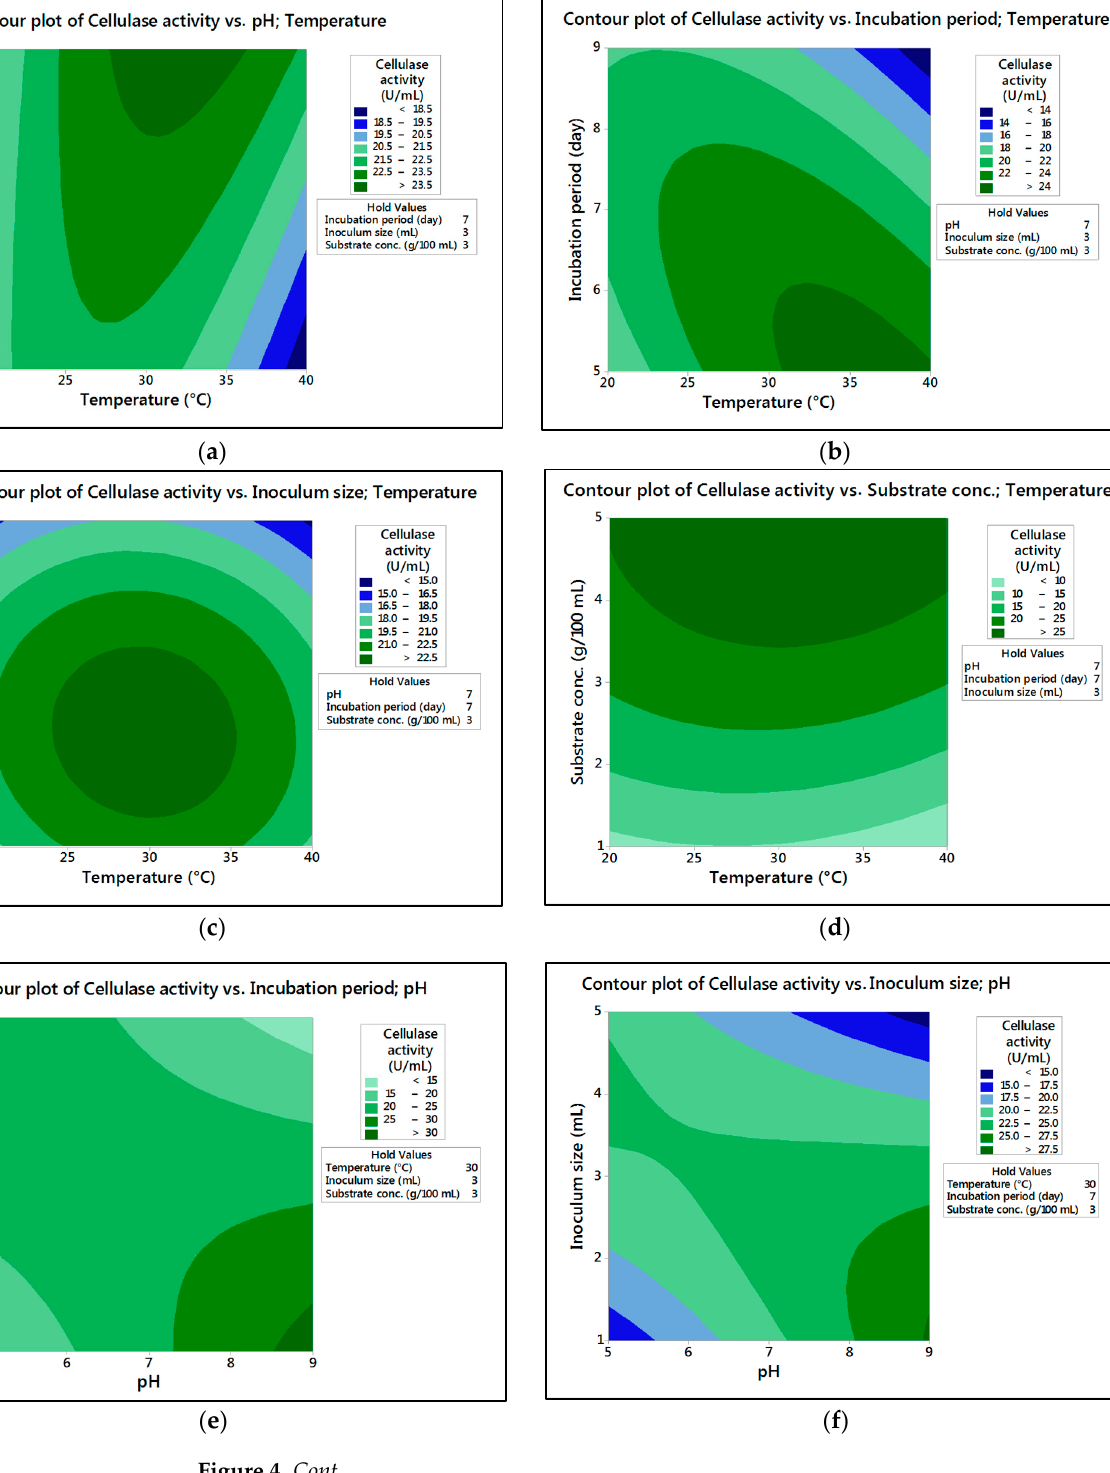
( j ) Figure 4. Contour plot showing interactions between independent variables: ( a ) incubation tem- perature with pH; ( b ) incubation temperature with incubation period; ( c ) incubation temperature with inoculum size; ( d ) incubation temperature with substrate concentration; ( e ) pH with incuba- tion period; ( f ) pH with inoculum size; ( g ) pH with substrate concentration; ( h ) incubation period with inoculum size; ( i ) incubation period with substrate concentration; ( j ) inoculum size with sub- strate concentration for cellulase activity produced by M. hiemalis .